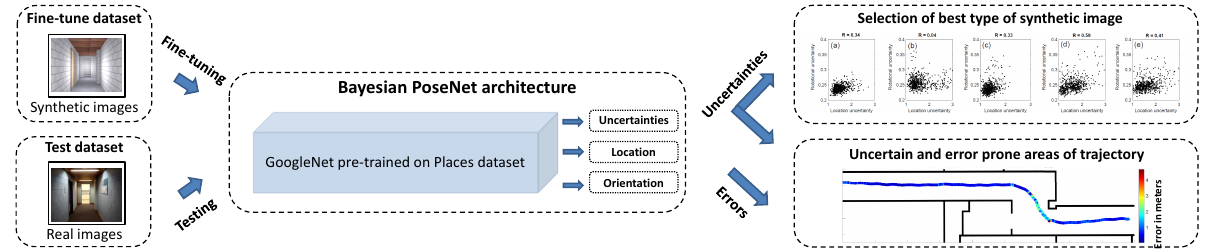
Figure 1. The design of the